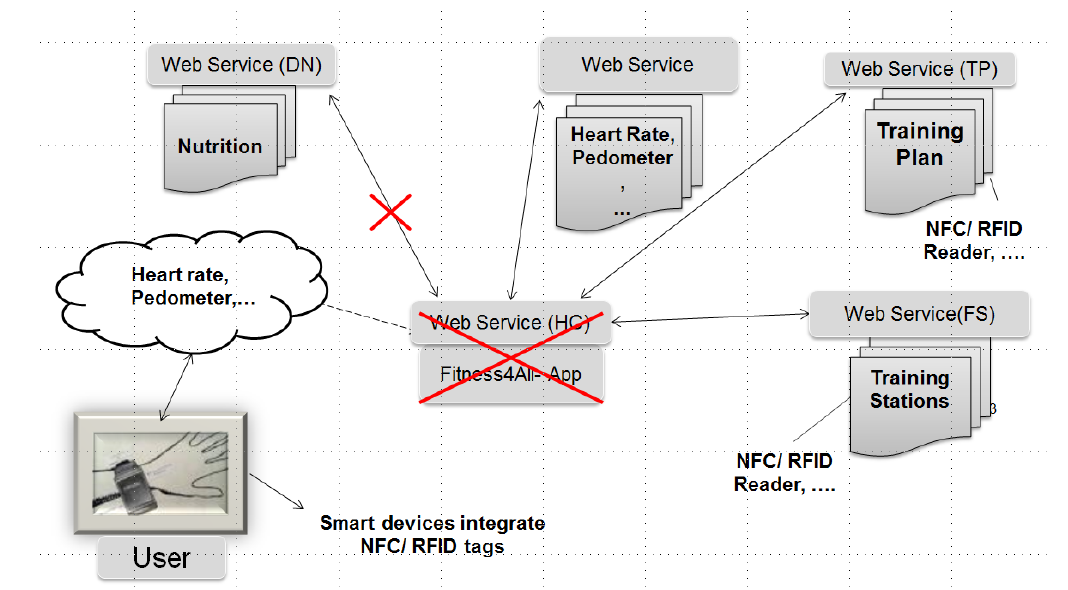
Figure 1. Fitness4All disrupts due to service